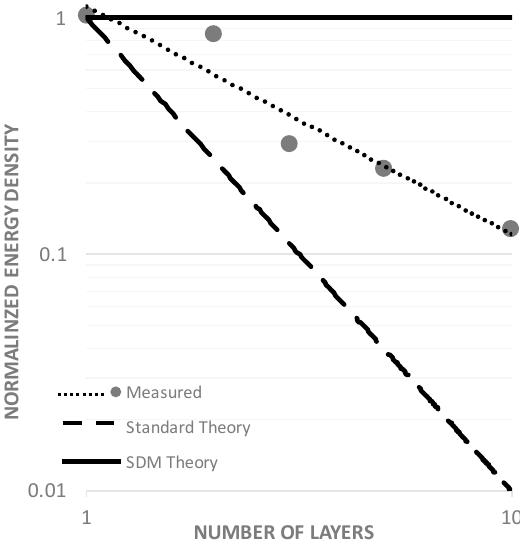
Figure 8. Energy Density vs. Thickness. According to SDM theory ( solid line), the energy density is independent of thickness. According to standard theory ( dashed line) the energy density falls as inverse thickness squared. The actual data ( points/dotted line) for energy density as a function of dielectric thickness fall between these two theories.